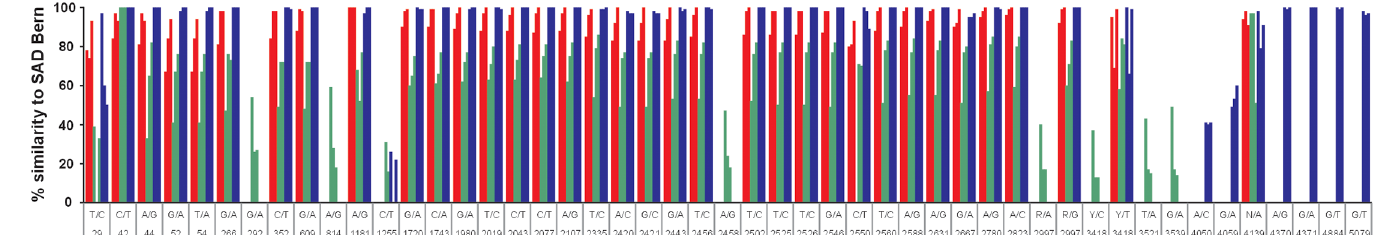
Fig 1. Strain mixtures present in 3 batches of Vaccine A (red columns), Vaccine B (blue columns) and Vaccine C (green columns). The figure represents the percentages of variants detected by 454 pyrosequencing. The SAD Bern genomic sequence (EF206708) was used as a reference. For example, three red columns show that the 3 Vaccine A batches differed from the SAD Bern reference sequences by more than 90%, i.e. the vaccine contained less than 10% of the SAD Bern strain. The description at the X axis shows the position relative to the referenced SAD Bern virus sequence (EF206708) and expected nucleotide present in the SAD Bern/observed nucleotide.